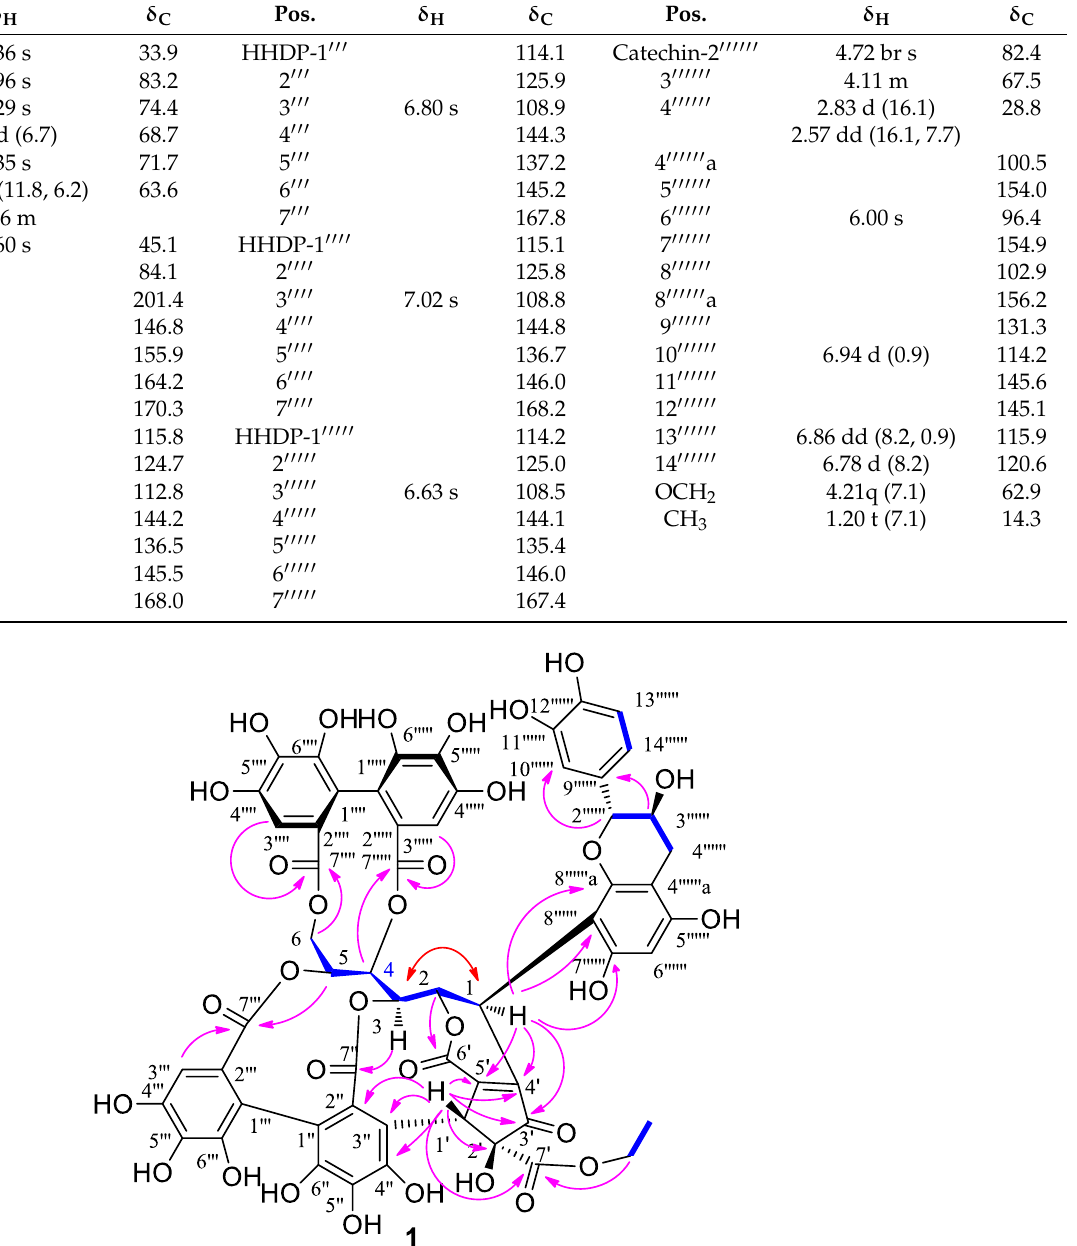
Figure 3. Key HMBC (arrows) of 11 . 2.2. Anti-Inflammatory Activity Assays All compounds except compounds 13 and 14 were investigated for potential anti- inflammatory activity by measuring the inhibition of the nitric oxide (NO) production. As shown in Table 3, compounds 1 , 11 , and 12 displayed significant anti-inflammatory activ- ity with IC 50 values ranging from 6.46 ± 0.23 to 9.82 ± 0.43 μM. The IC 50 values for the inhibition of NO production by other compounds are all > 10 μM. The anti -inflammatory